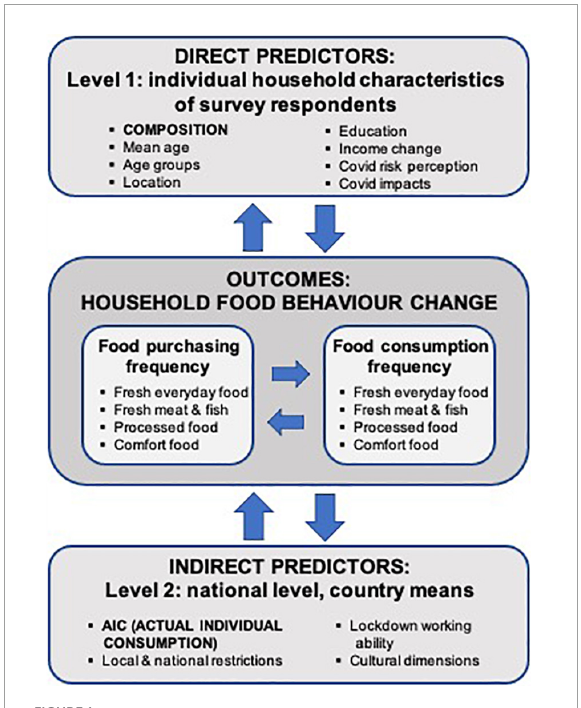
FIGURE1 Conceptual framework of both direct and indirect predictors of households’ food change during